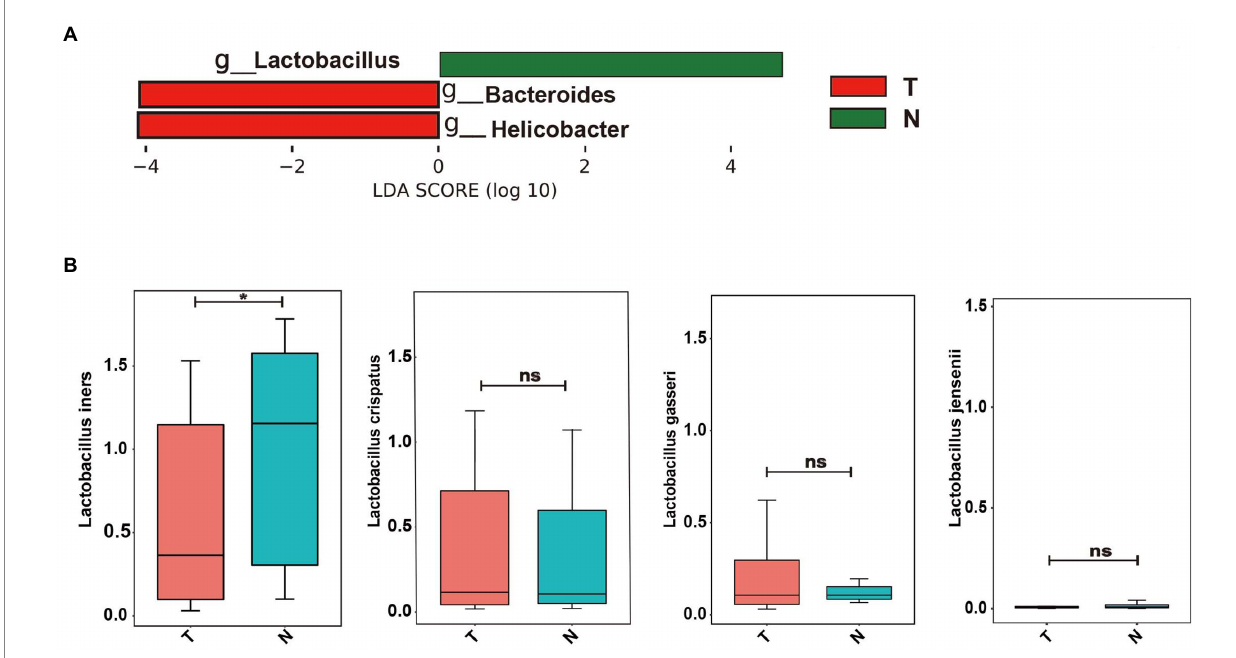
FIGURE 3 Bacterial taxa analysis of the embryo-arrest and normal pregnancy groups. (A) linear discriminant analysis (LDA) scores obtained from the linear discriminant analysis effect size (LEfSe) analysis of the vaginal microbiota in the two groups. (B) Relative abundance of Lactobacillus is reported with SEM as bar plots. An LDA effect size of > 4 was used as a threshold for the LEfSe analysis. T, embryo-arrest group; N, normal pregnancy group. LDA, linear discriminant analysis; LEfSe, LDA effect size